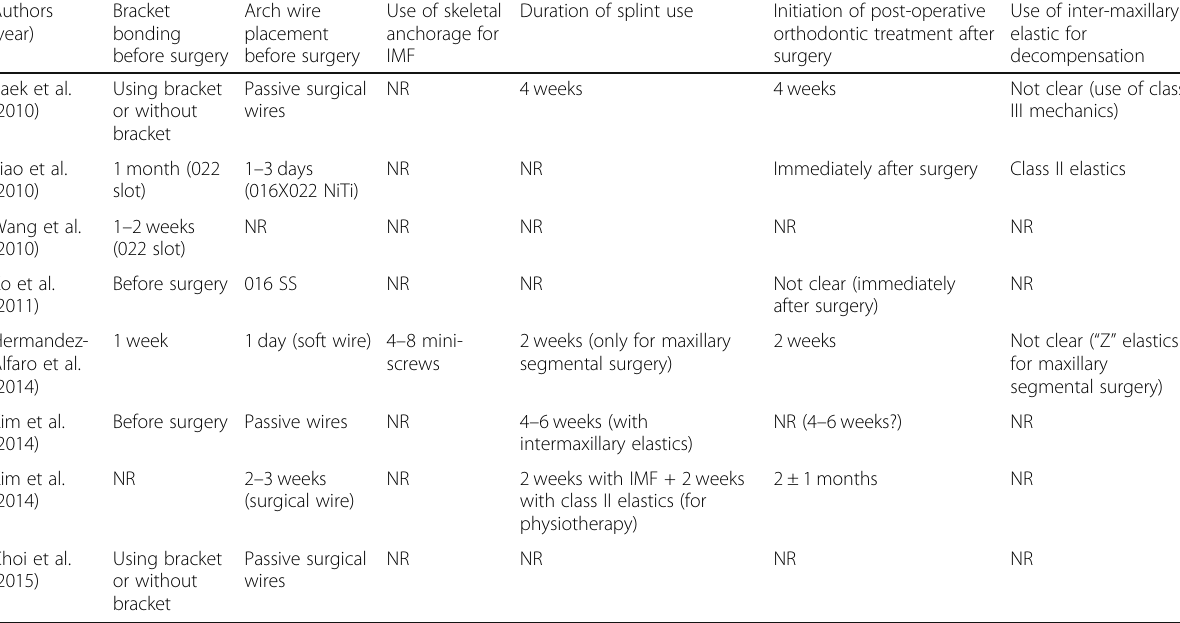
Table 2 Literature overview of post-operative orthodontic treatment in the surgery-first approach Authors